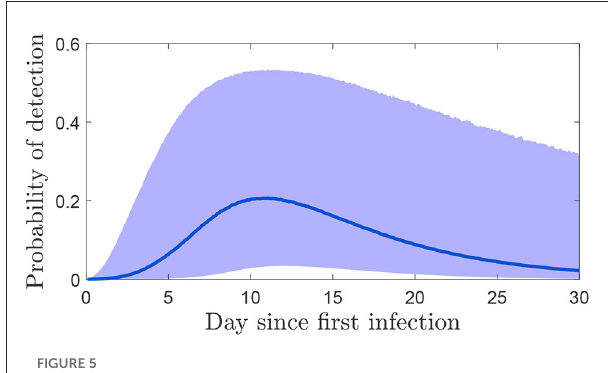
FIGURE5 The probability (median and 95% credible interval) of detecting FMDV from a single sample on each day post infection. FIGURE6